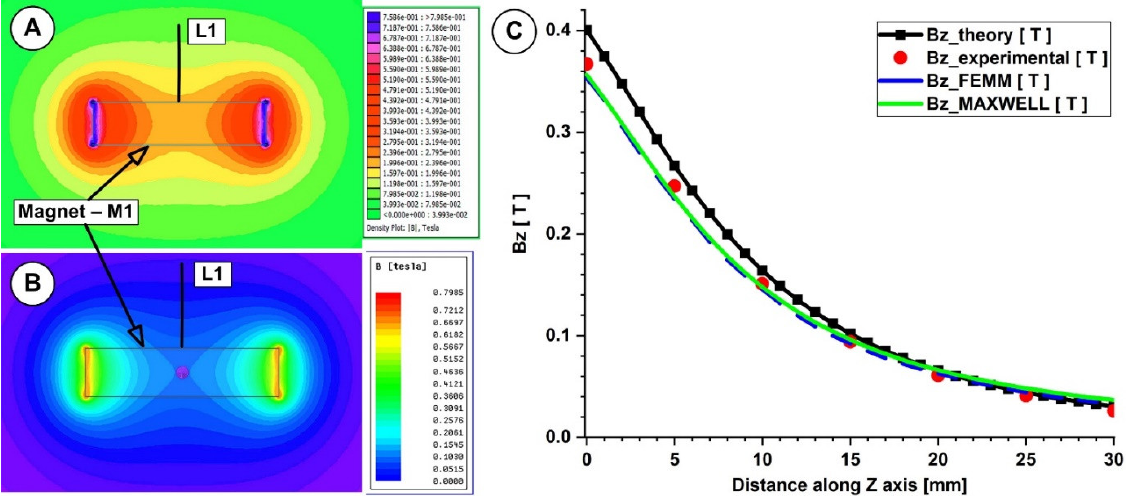
Figure 6. Theoretical and numerical investigations of the magnetic field generated by the magnet M1 (40×20×10 mm), type NdFeB grade N52. Numerical results: ( A ) using FEMM 4.2, ( B ) using Ansys Maxwell. ( C ) B z evolution function of the magnet surface distance. Comparison between theoretical, experimental, and numerical results.